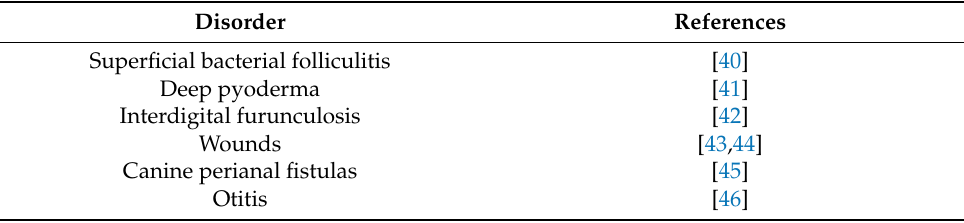
Table 2. Overview of clinical FBM applications in canine